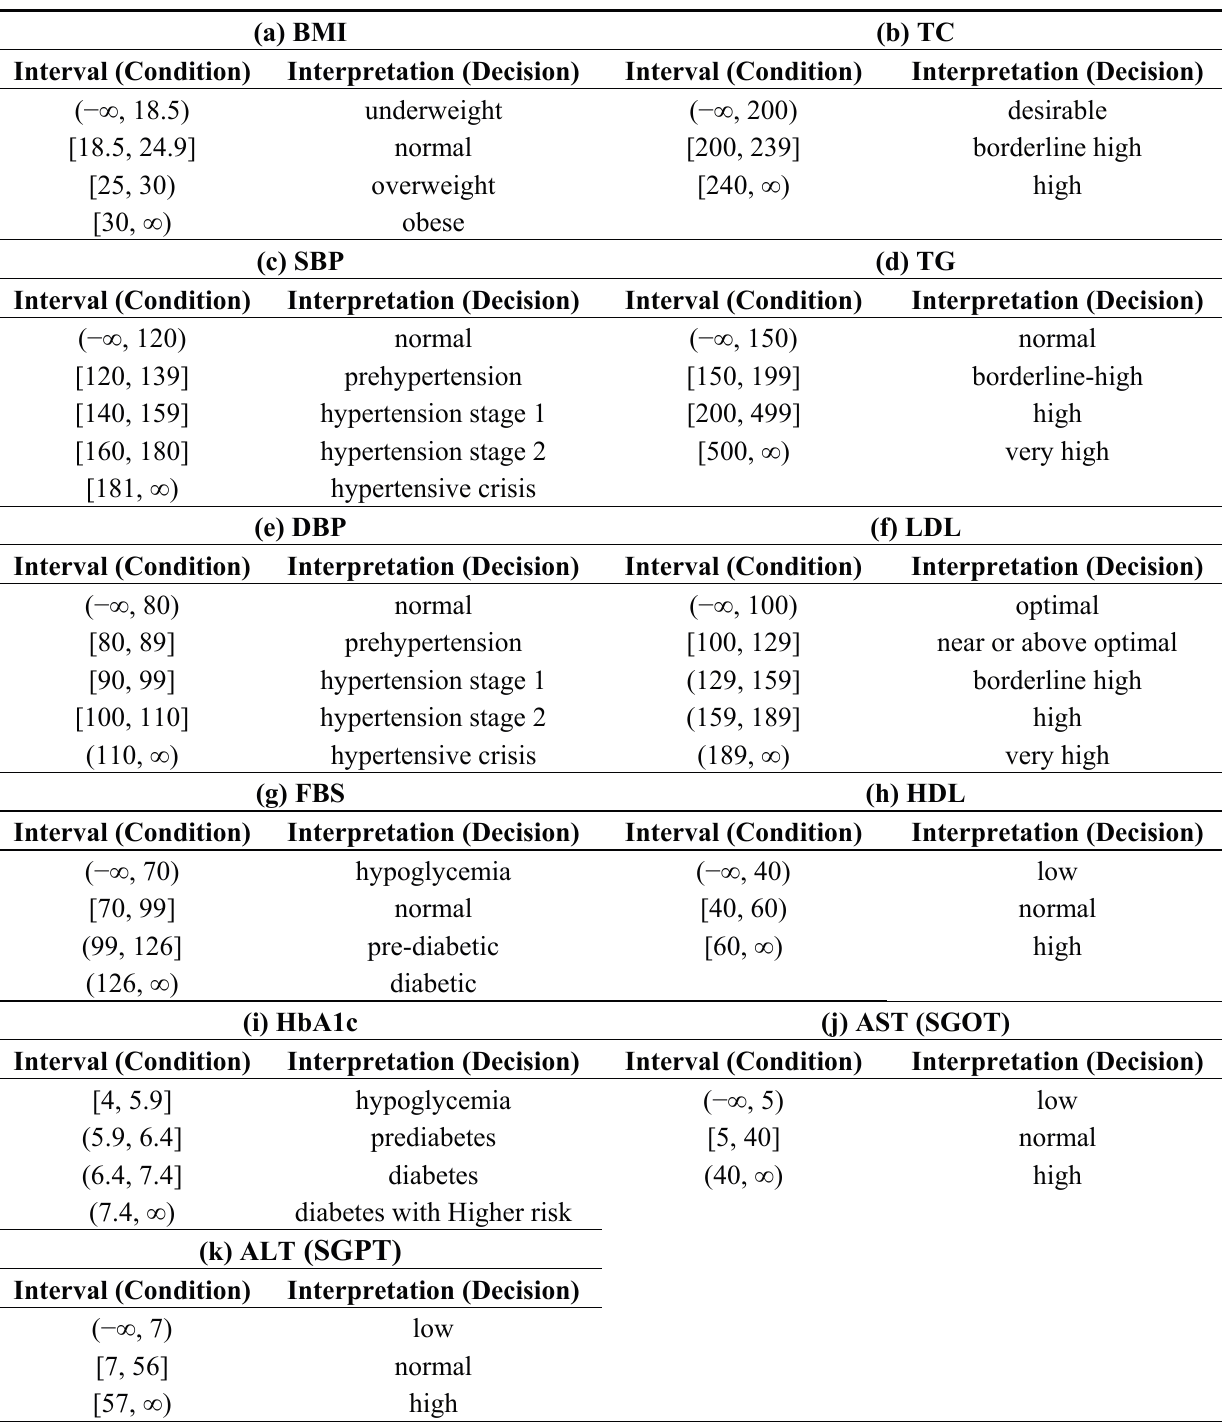
Table 2. Rules defined for management of diabetics observations, based on reference ranges, extracted from guidelines (Table